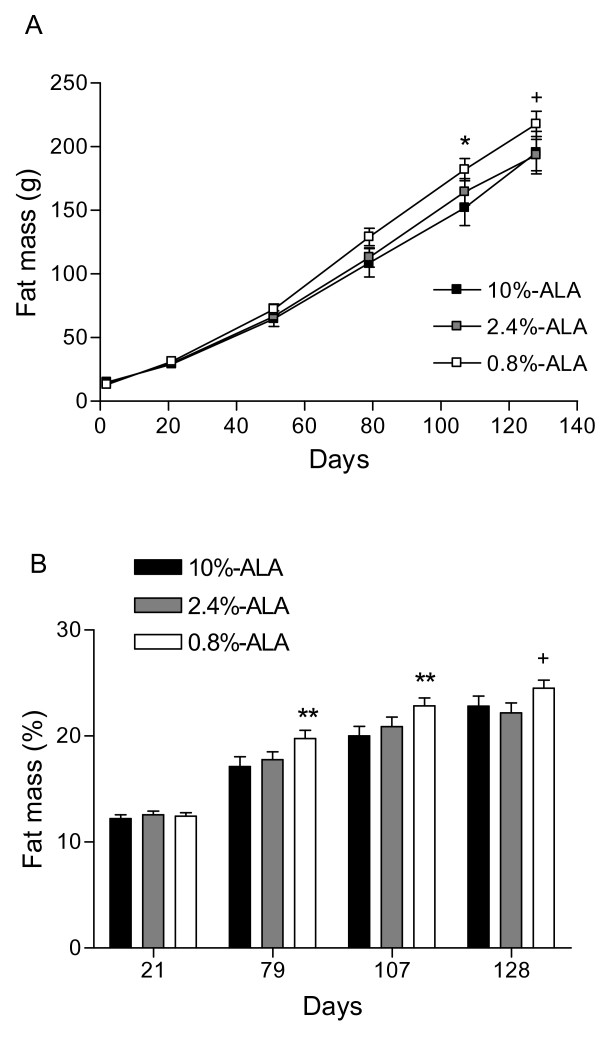
Fat mass evolution. (A) Fat mass (g) evolution from d21 to 128. (B) Fat mass (% of body weight) at 21, 79, 107 and 128 days. Data are means ± SE, n = 15-20 guinea pigs/group. + indicates p < 0.05 between the 0.8%-ALA and 2.4%-ALA or 10%-ALA groups. * indicates p < 0.05 and ** indicates p < 0.01 between the 0.8%-ALA and 10%-ALA groups.